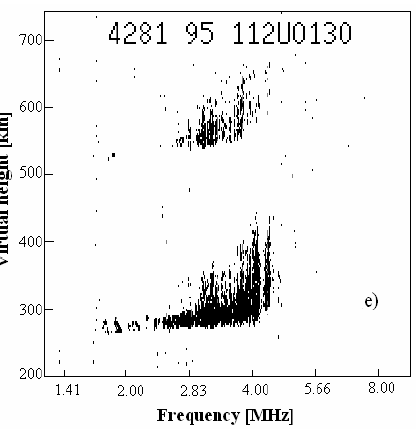
Fig. 7. Ionogram sequences showing the different ESF-types observed in this work, (a) b-type ESF (bottom-spread): An illustration of a local-seed event, (b) P-type ESF (F-layer peak spread): The seed event has changed to a large-scale structure at the F-layer peak, (c) mixture of P and R-type ESFs (where R denotes the classical range-spread), (d) I-type ESF (Inside-extended echo): Follows the P-type ESF at the descent of the F-layer and lasts the longest time, (e) F-type ESF